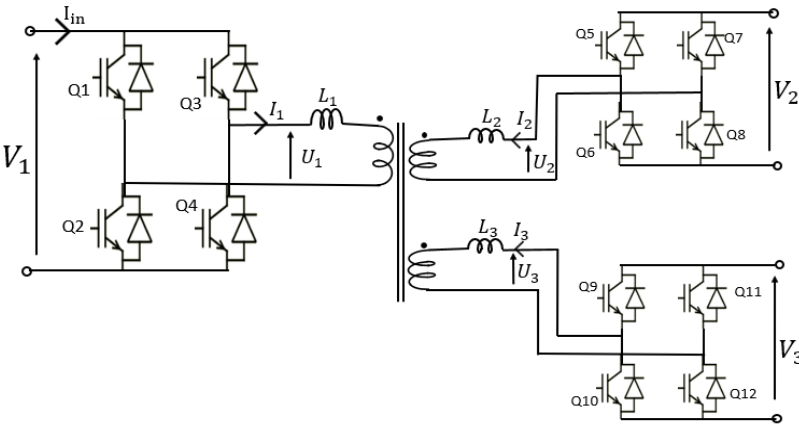
Figure 2. The three-port DC–DC converter showing the different H-bridges.